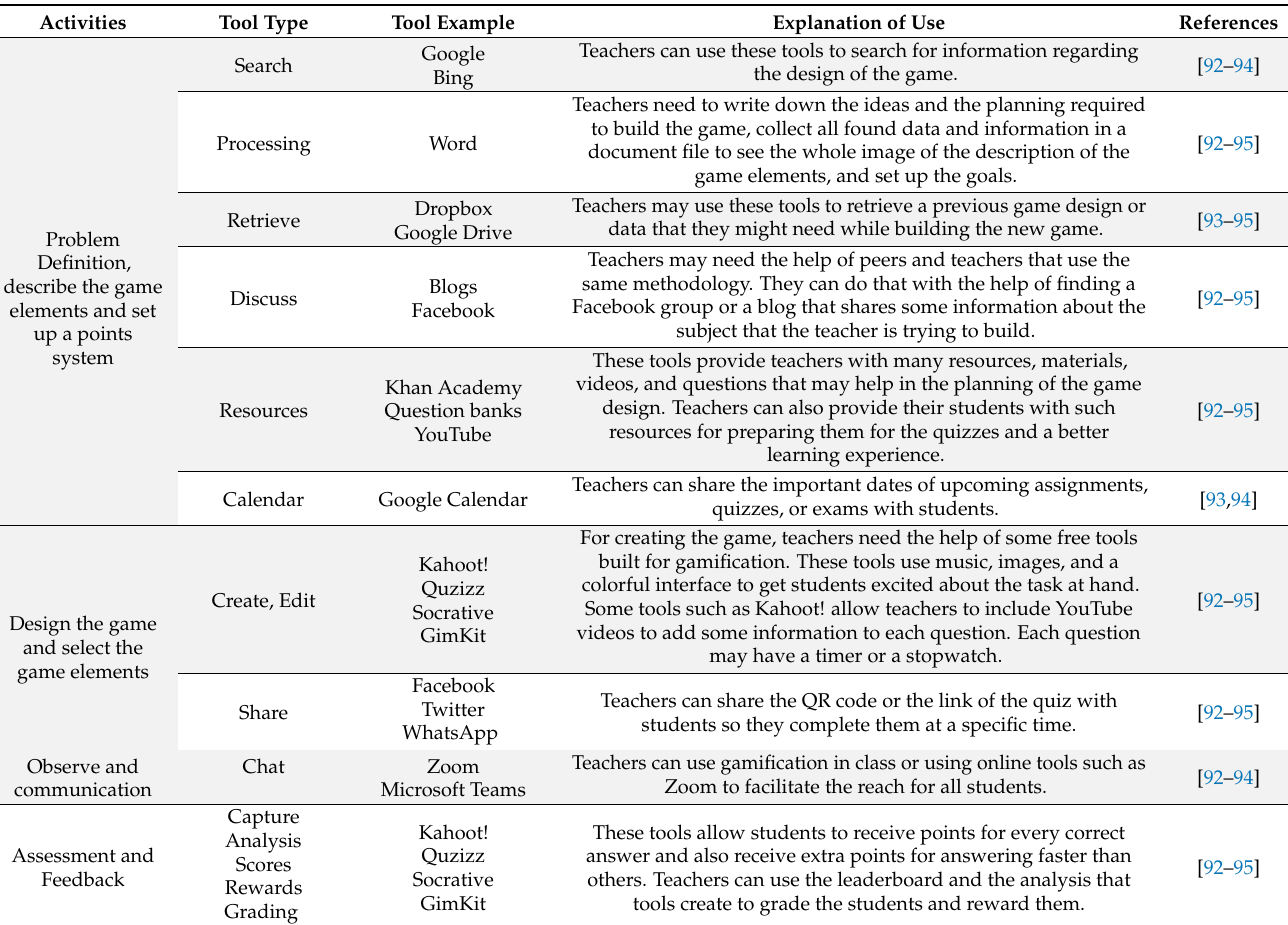
Table 5. PTE guide for